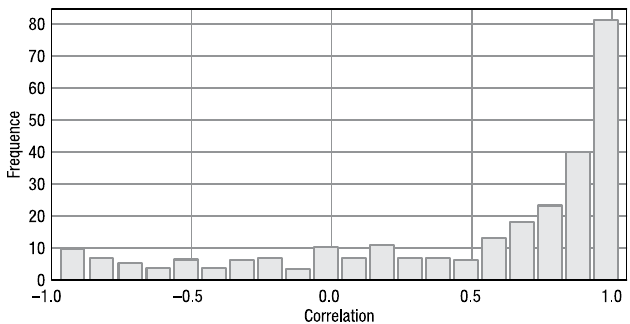
Fig. 3. Statistical analysis of the model’s accuracy (200